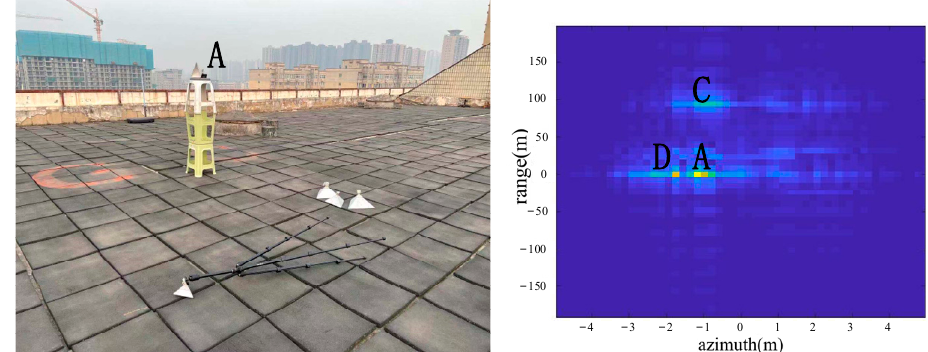
Sensors 2022 , 22 , x FOR PEER REVIEW Figure 10. The 5th group of experimental scenes and imaging results. Figure 10. The 5th group of experimental scenes and imaging results.